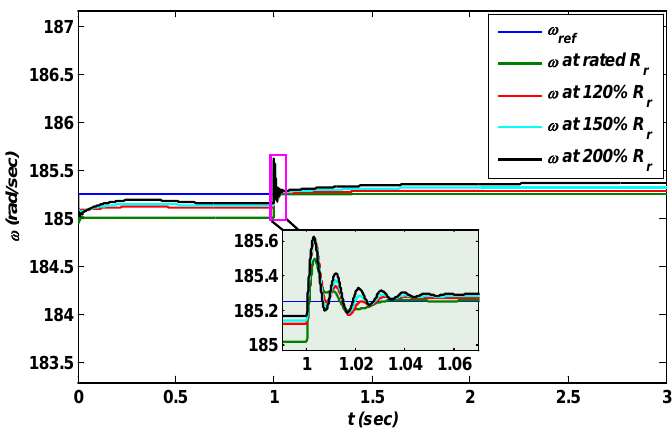
Figure 15. Speed control of IFOC IM using Sliding Mode Control (SMC). Energies 2018 , 11 , x FOR PEER REVIEW